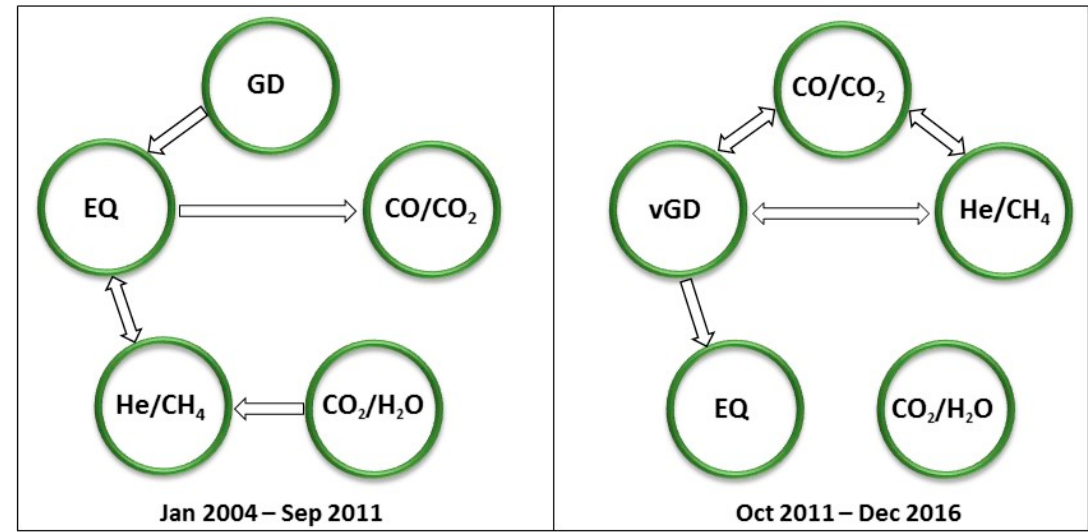
Figure 4. Granger test results for two sub-periods. Arrow indicates Granger unidirectional causality; double-ended arrow indicates Granger bidirectional causality (feedback) between two variables.